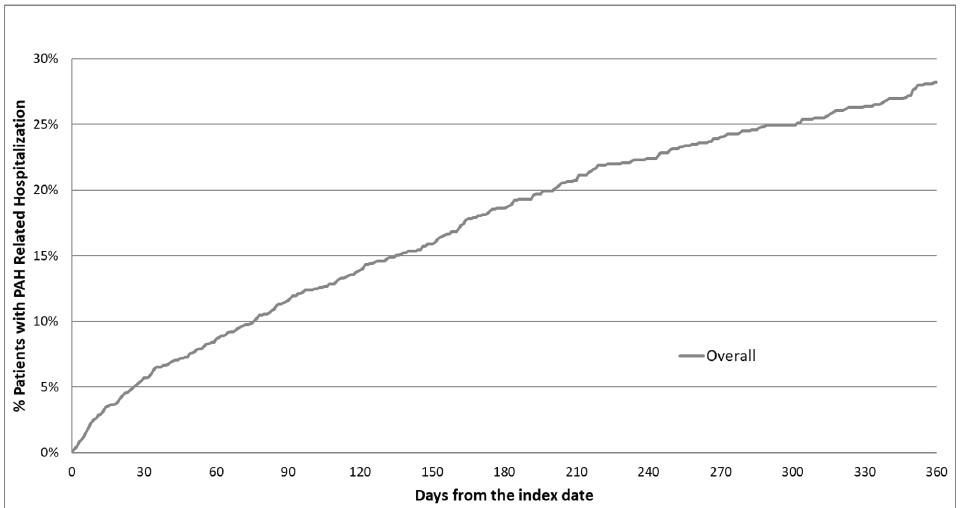
Figure 4. Kaplan-Meier Analysis: Time to First PAH-related Hospitalization During the 12-month Postindex